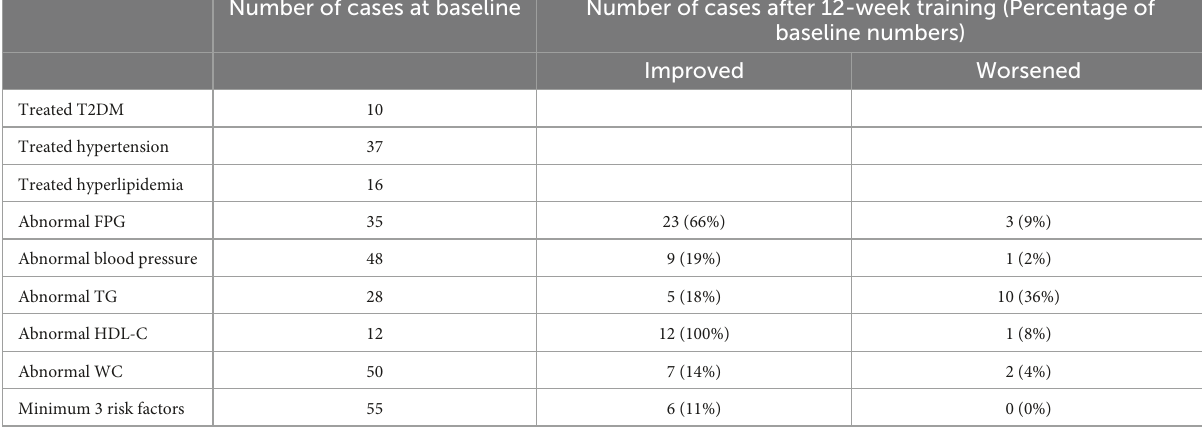
TABLE 6 Metabolic syndrome risk factors at baseline and after training